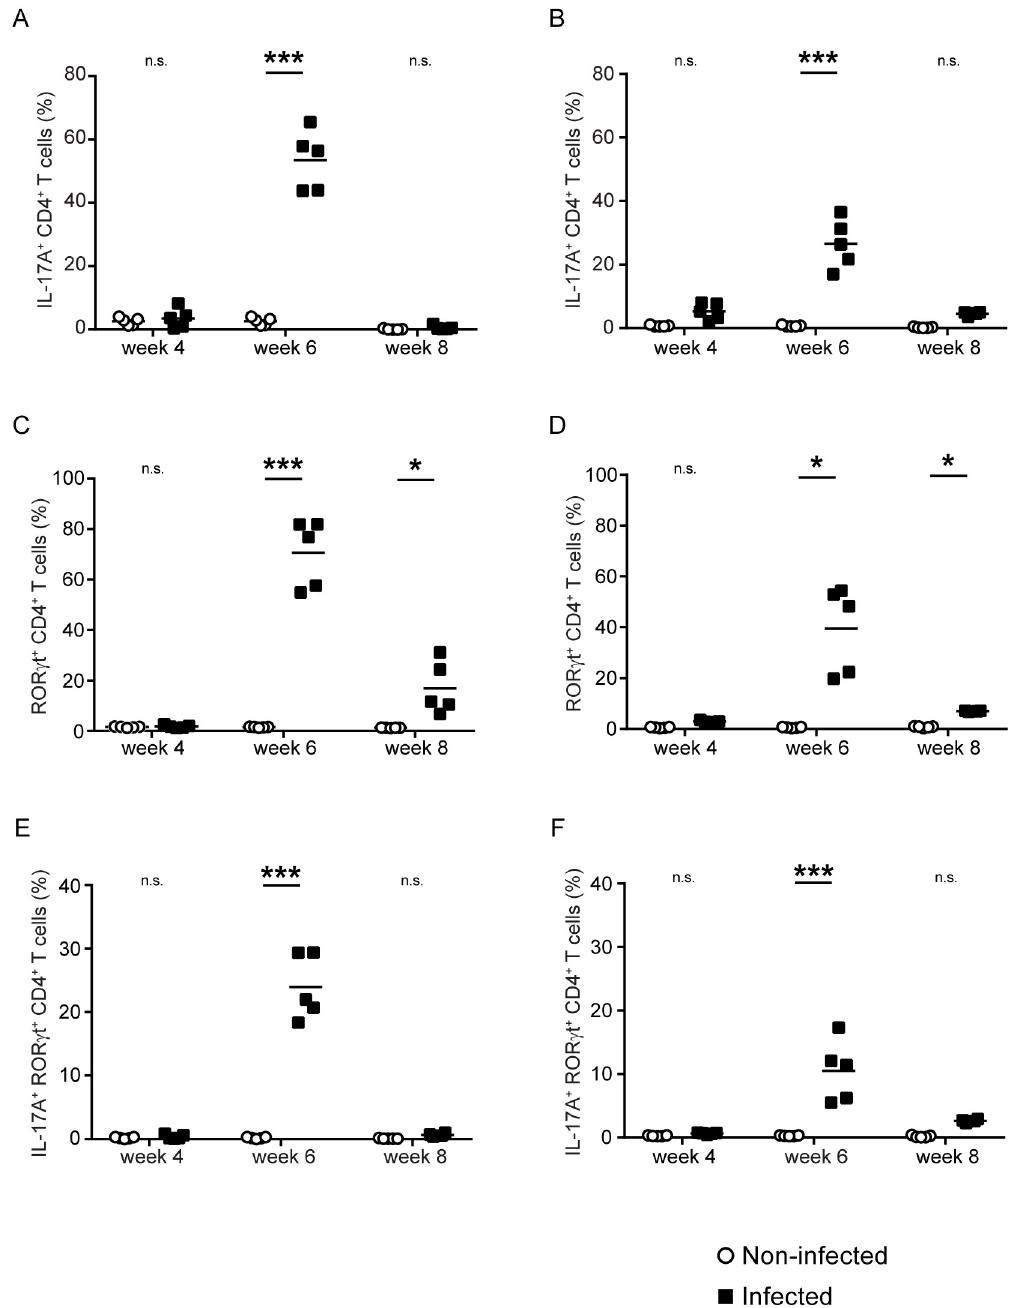
Fig 5. Acute schistosome infection induces a transient T H 17 response in the spleen and mesenteric lymph nodes. Using intracellular cytokine/transcription factor staining and flow cytometry, the frequency of IL-17A + CD4 + T cells (A, B), ROR γ t + CD4 + T cells (C-D), and double-positive IL-17A + ROR γ t + CD4 + T cells (E, F) in the spleens (A, C, E) and mesenteric lymph nodes (B, D, F) of S . mansoni -infected C57BL/6 mice, was determined at 4, 6 and 8 weeks post infection. Non-infected mice were included at each time point, as negative controls. n.s., P > 0.05; � , P < 0.05; ��� , P < 0.001.